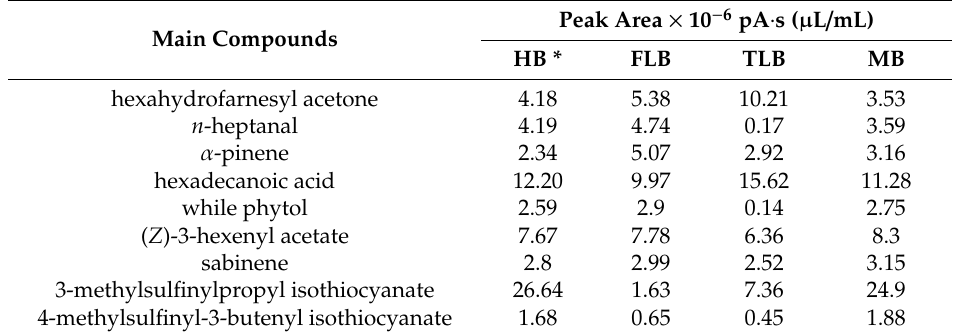
Table 2. The peak area of the main volatile compounds emitted from multi-treated Barbarea vulgaris plants.